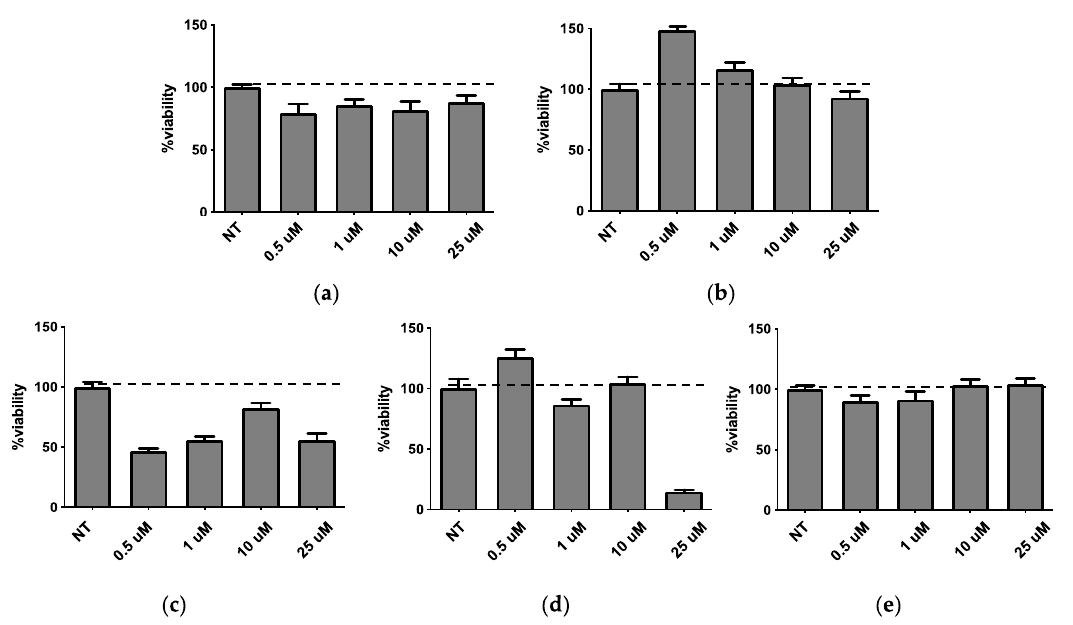
Figure 6. Effect on A549 pulmonary cells viability (MTT assay) after 24h of treatment with LP-P ( a ), LP-DCP ( b ), LP-DDAC ( c ), LP-DEBDA ( d ) and LP-SA ( e ).